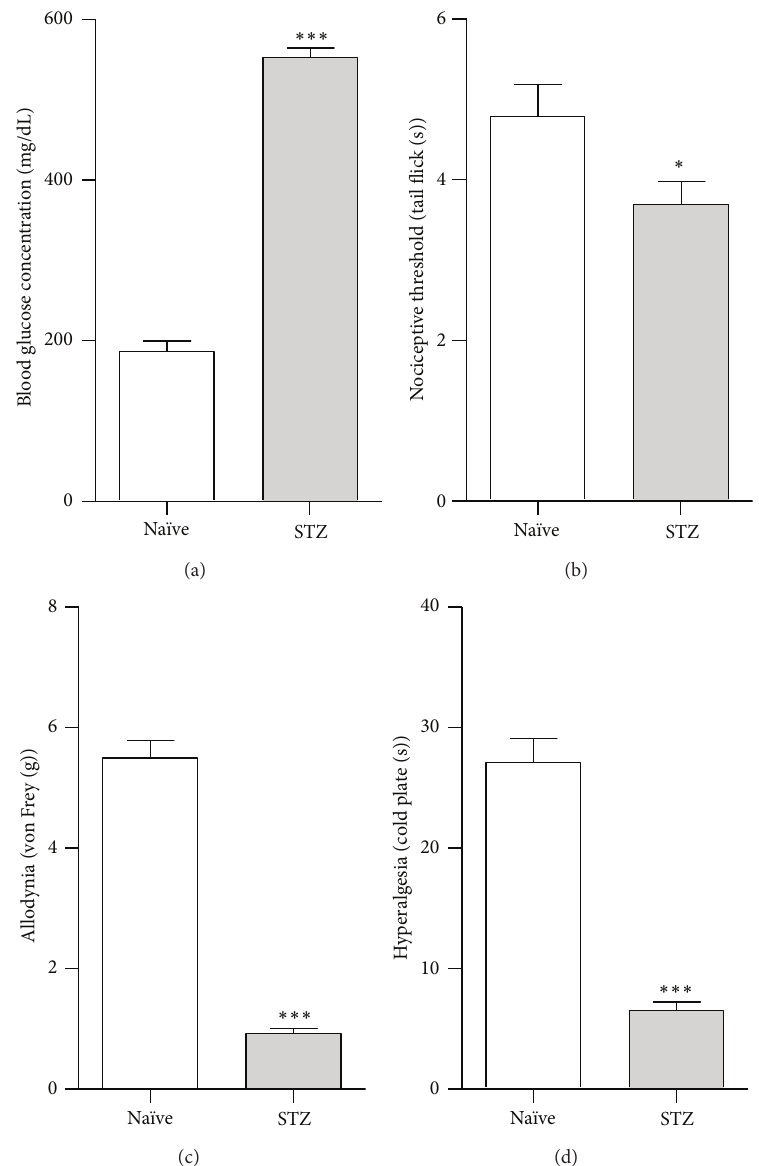
Figure 1: Mouse streptozotocin (STZ) model of diabetic neuropathy. Effects of single STZ (200 mg/kg; i.p. ) administration on plasma glucose concentration (a); nociceptive threshold (tail-flick test) (b); allodynia (von Frey test) (c); and hyperalgesia (cold plate test) (d) measured at day 7. The data are presented as the mean ± S.E.M. (4–16 mice per group). The results were evaluated using Student’s 𝑡 -test. ∗ 𝑃 < 0.05 and ∗∗∗ 𝑃 < 0.001 indicate a significant difference versus na¨ıve